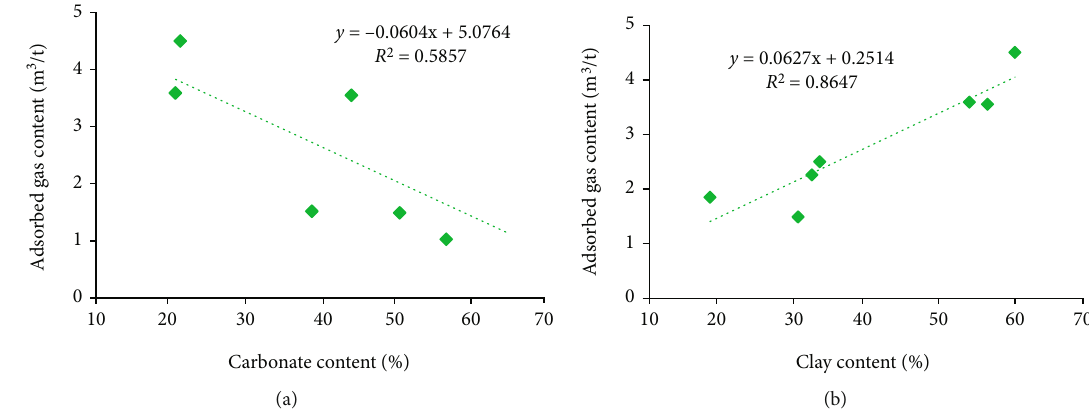
Figure 5: The relationship between (a) carbonate content, (b) carbonate minerals content, and adsorbed gas